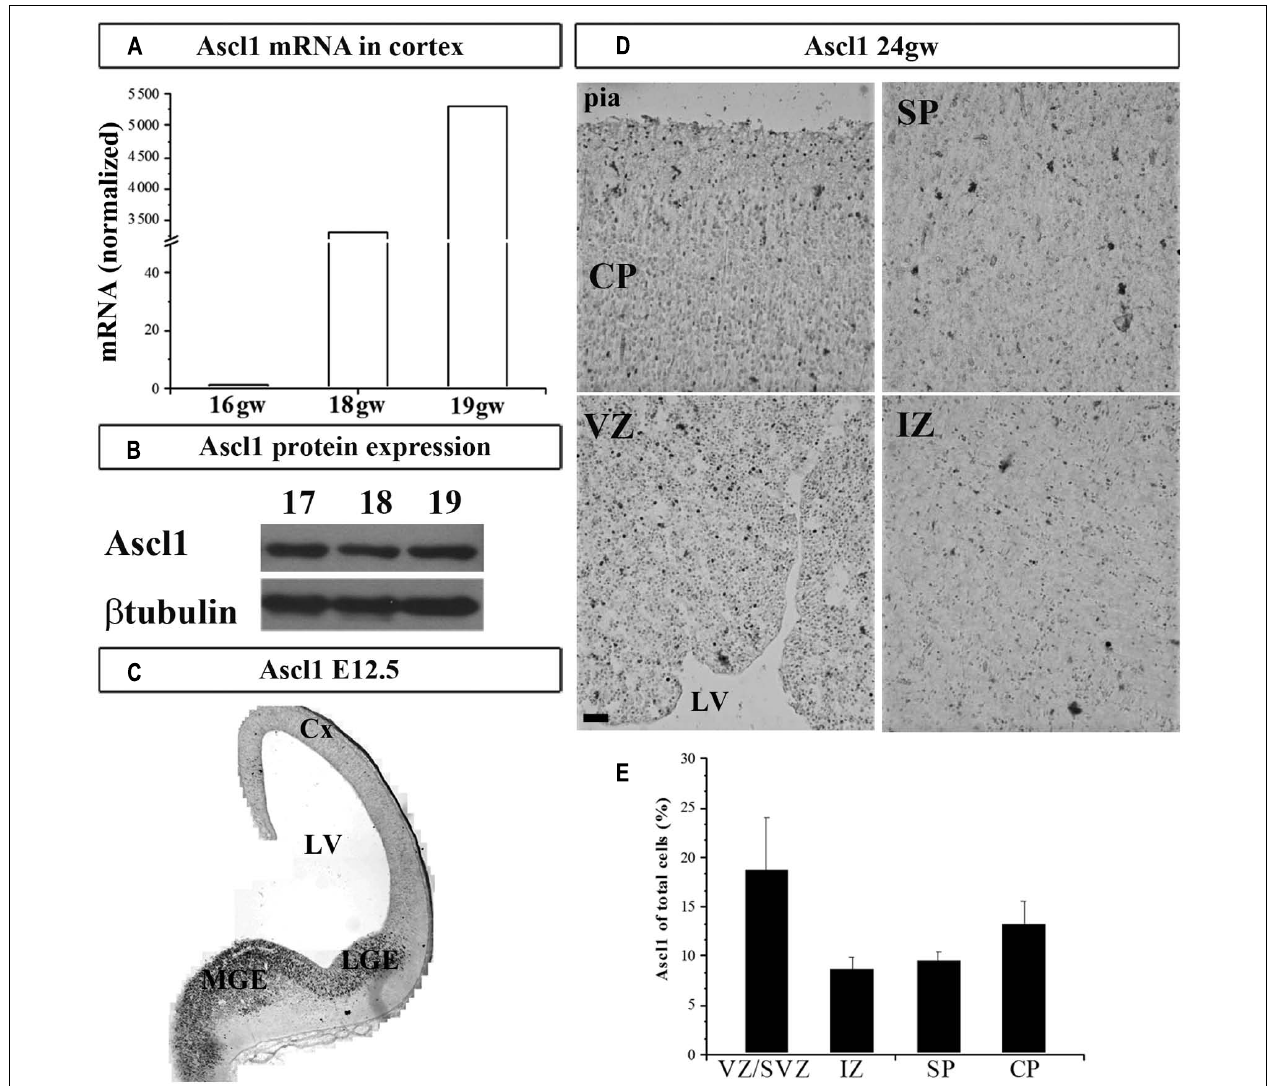
midgestation (21–24 gw). Data are presented as mean values + standard error of the mean (minimum three sections from two brains were studied). VZ/SVZ, ventricular/subventricular zone; IZ, intermediate zone; SP, subplate; CP, cortical plate; Cx, cortex; LV, lateral ventricle; CGE, caudal ganglionic eminence; MGE, medial ganglionic eminence. Scale bar 50 μ